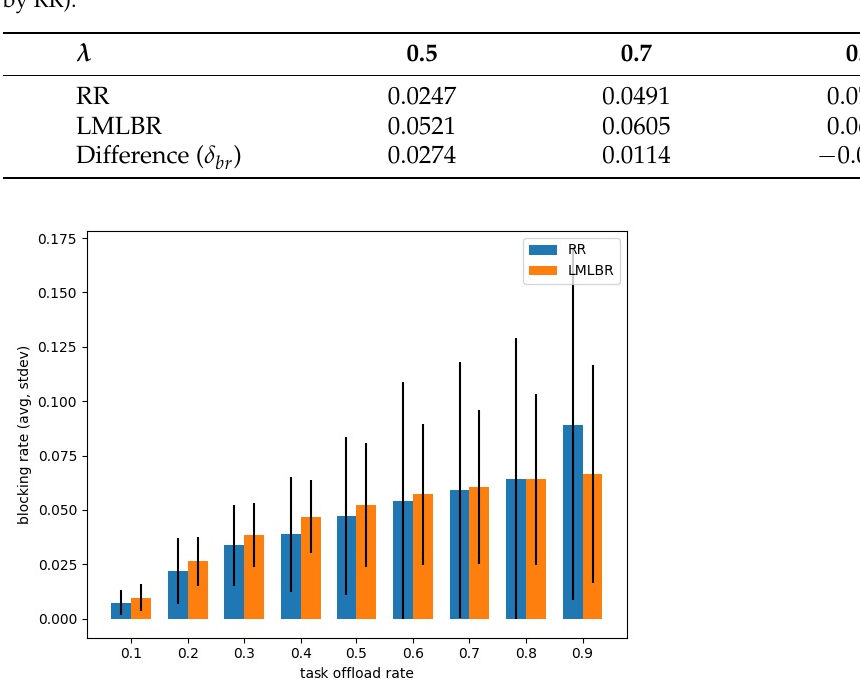
Figure 4. Average task blocking rate for various task offload rates. Table 3. Comparison of RR and LMLBR in terms of the average task blocking rate (Difference ( δ br ) represents the average blocking rate obtained by LMLBR minus the average blocking rate obtained by RR).